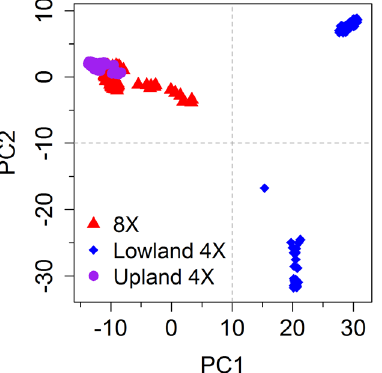
Figure 1. First two principal components of 16,669 single nucleotide polymorphisms separate plants by ploidy and ecotype. The first and second principal components (x- and y-axis, respectively) from a principal component analysis of 540 switchgrass closes separate octoploid (8X) and upland tetraploid (4X) accessions from lowland 4X accessions. The lowland accessions are also separated into two distinct clusters.